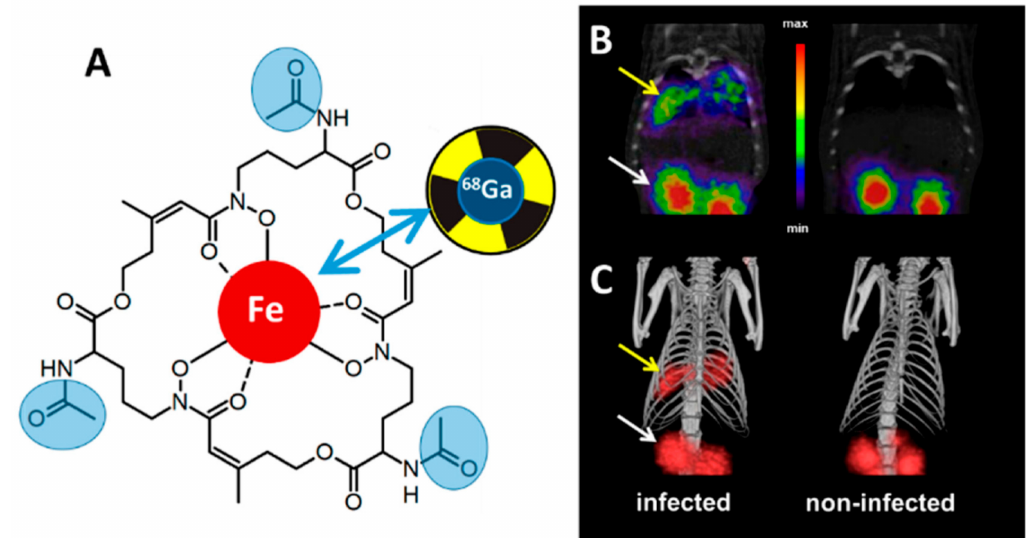
Figure 4. Radiolabelled siderophore imaging of Aspergillosis in a rat model. ( A ) Possible chelation of Fe(III) or 68 Ga by Triacetylfusarinine C (TAFC). Possible chemical modification sites are highlighted in blue. ( B ) µ PET / Computed Tomography coronal slices and ( C ) volume rendered 3D images rat infected by A. fumigatus after injection of [ 68 Ga]Ga-TAFC showing accumulation in the lungs (yellow arrow) and excretion through the kidneys (white arrow) of the radiotracer. Adapted from Petrik et al. J. Fungi 2020, 6